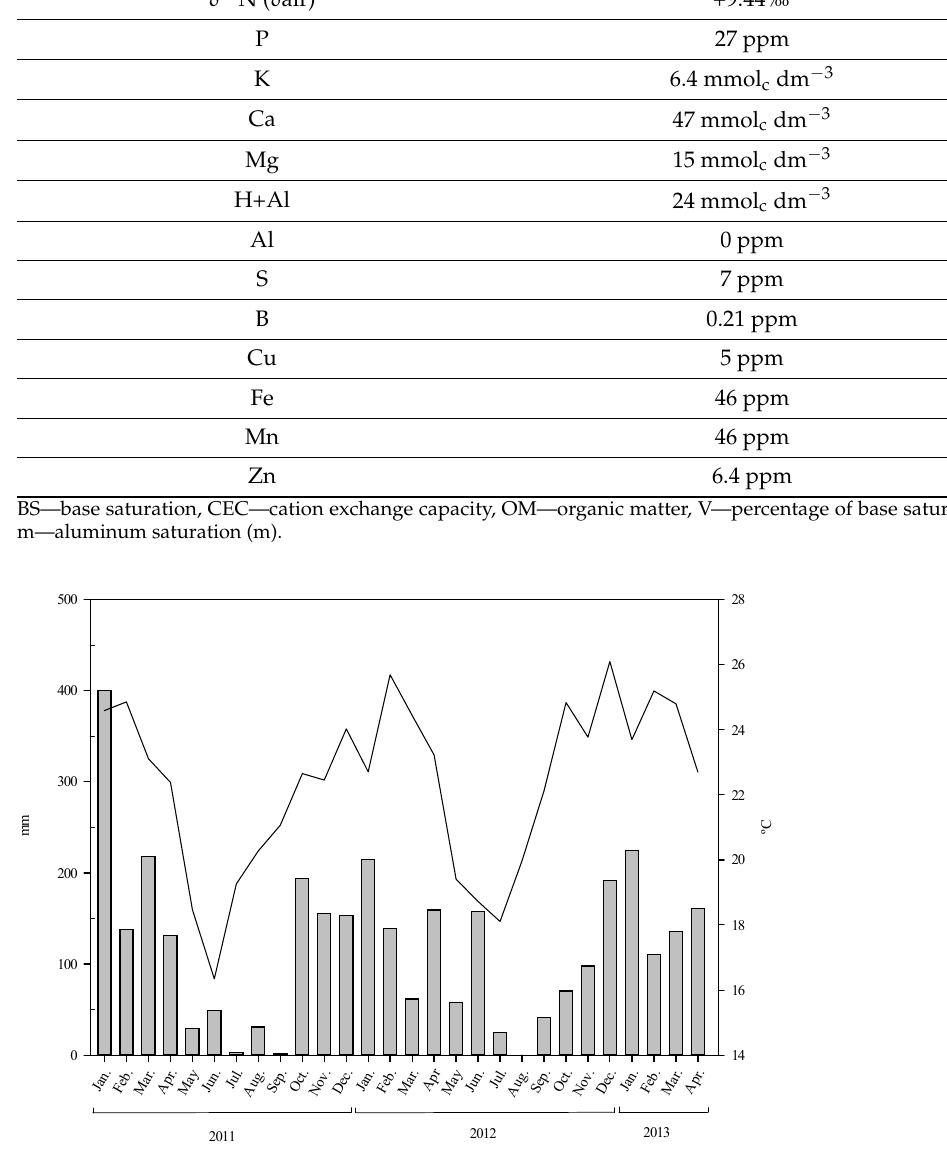
Figure 2. Illustration of succession system of green corn and cherry tomato/legumes with their respective spacing between the lines.